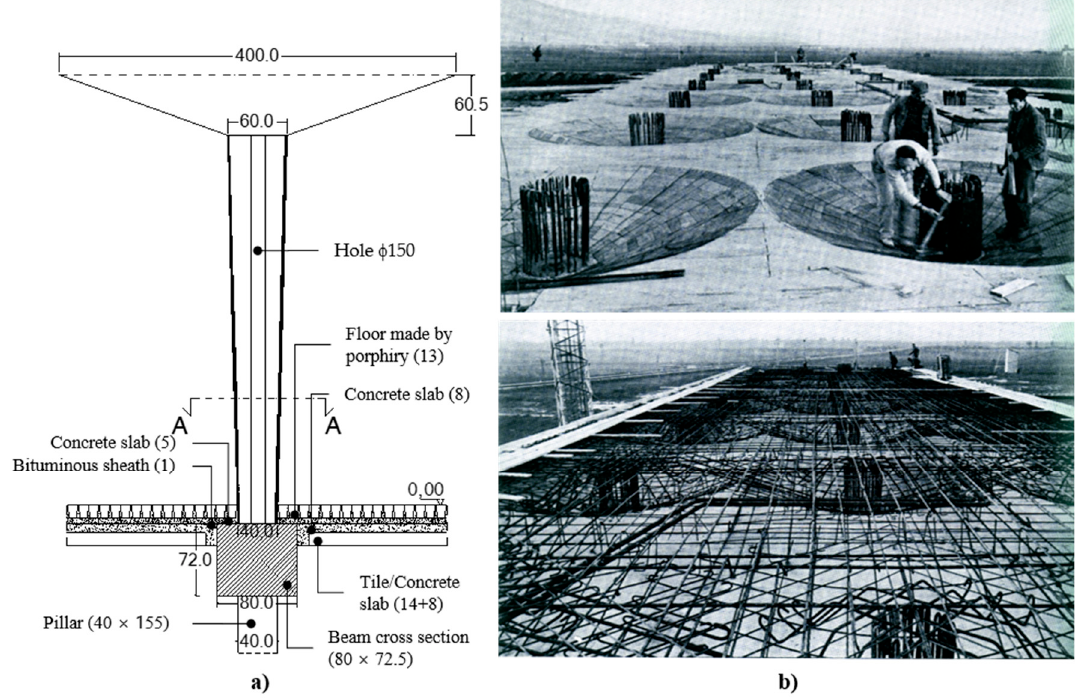
Figure 3. The peculiar mushroom-shaped columns of the ground floor: ( a ) vertical section, and ( b ) archive pictures of their prefabrication in situ (all dimensions in cm).